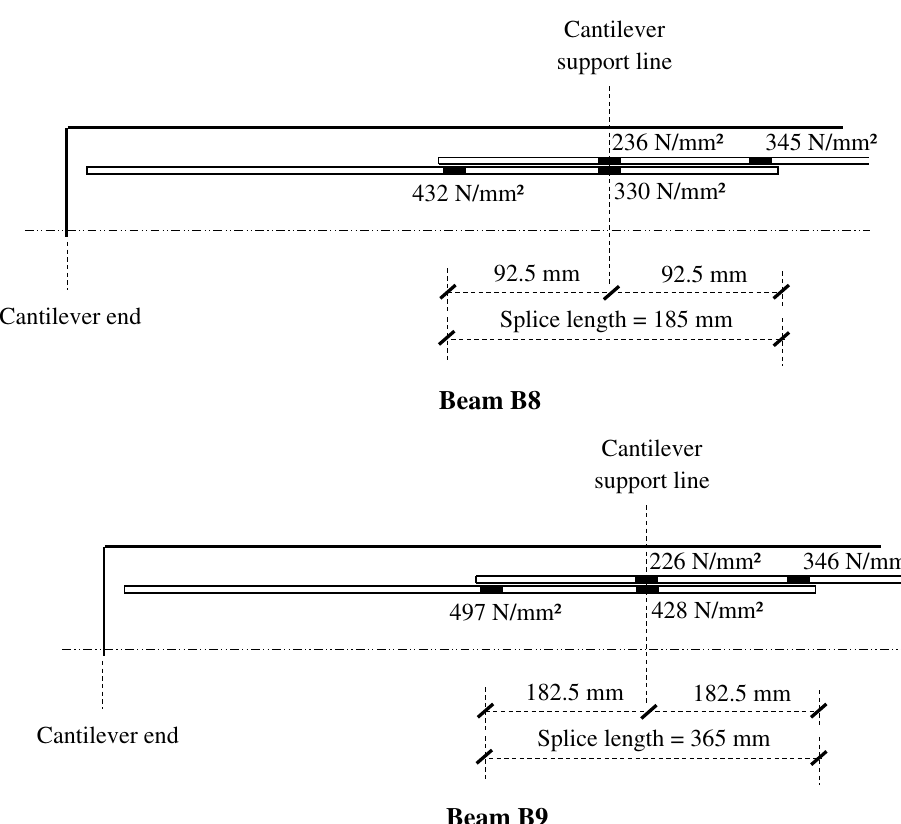
Fig. 21 Ultimate steel stress values calculated from steel strains at strain gauges’ locations shown in Fig. 2 (Shear links omitted for clarity) Not to scale